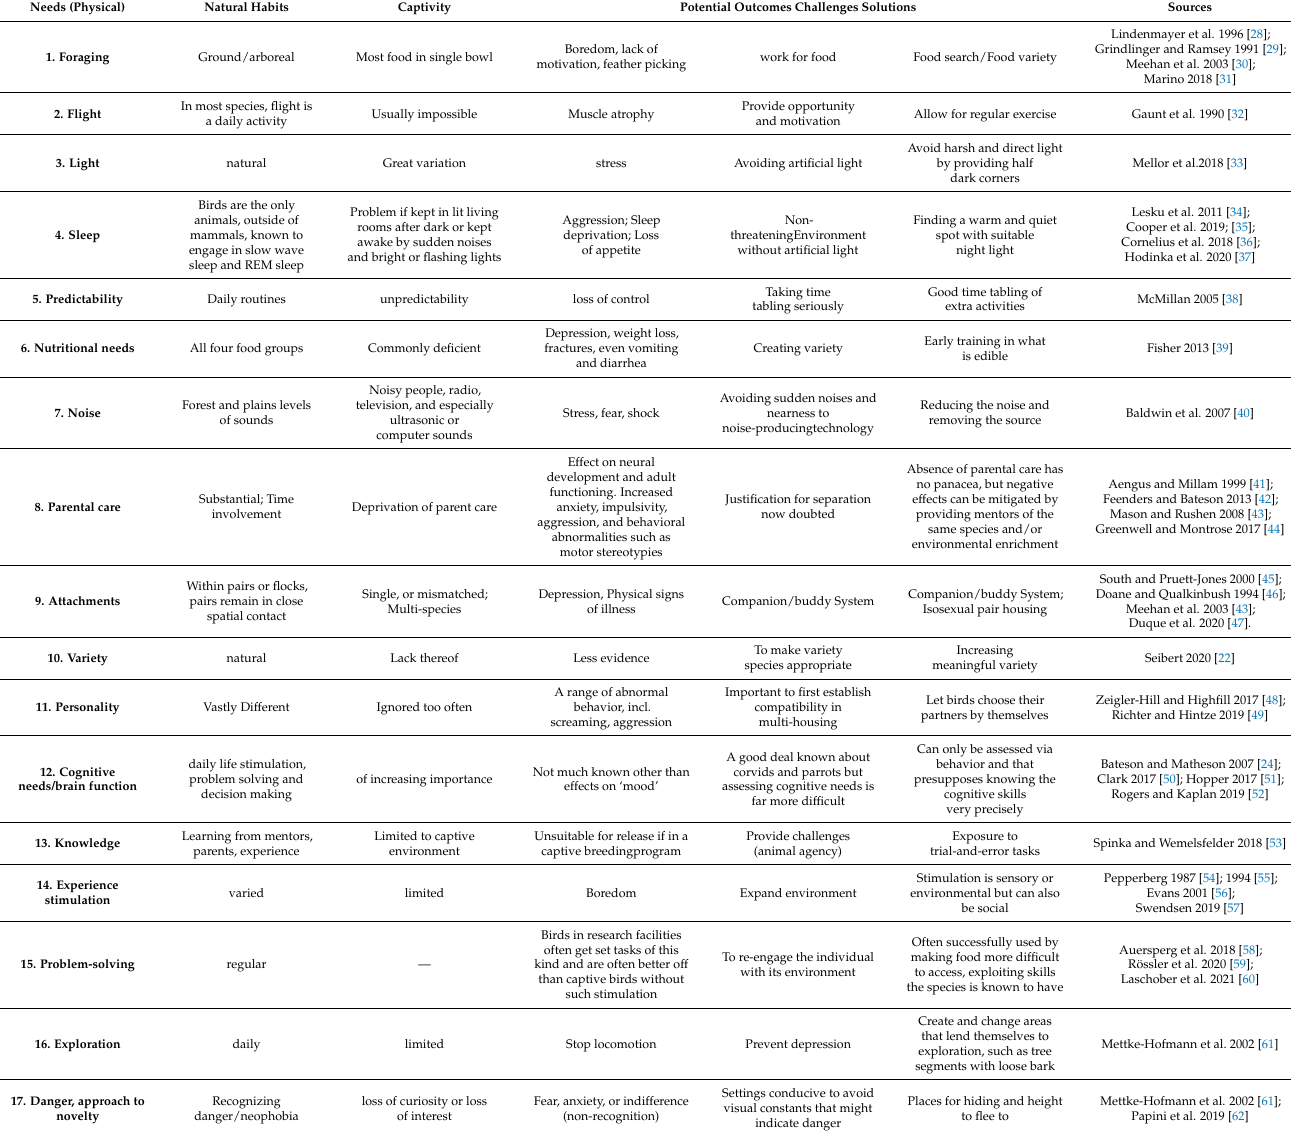
Table 1. Common Behavioral Problems in Caged Birds (of several